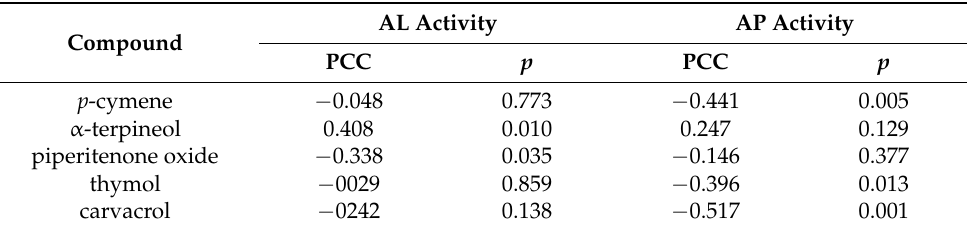
Table 3. Pearson correlation coefficients between main components of EOs and AL and AP activities.